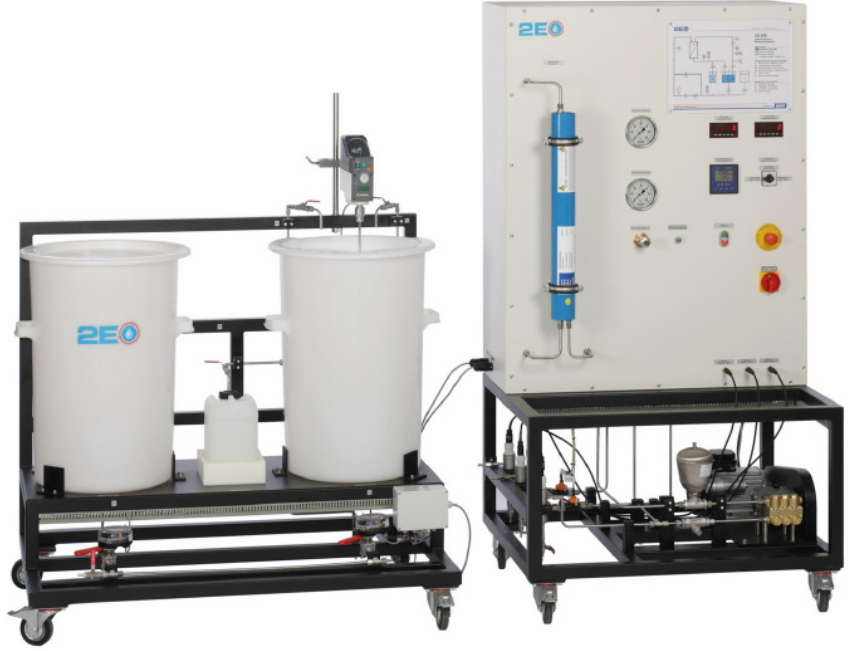
Figure 6. CE 530 Figure 6. CE 530 RO-Setup.